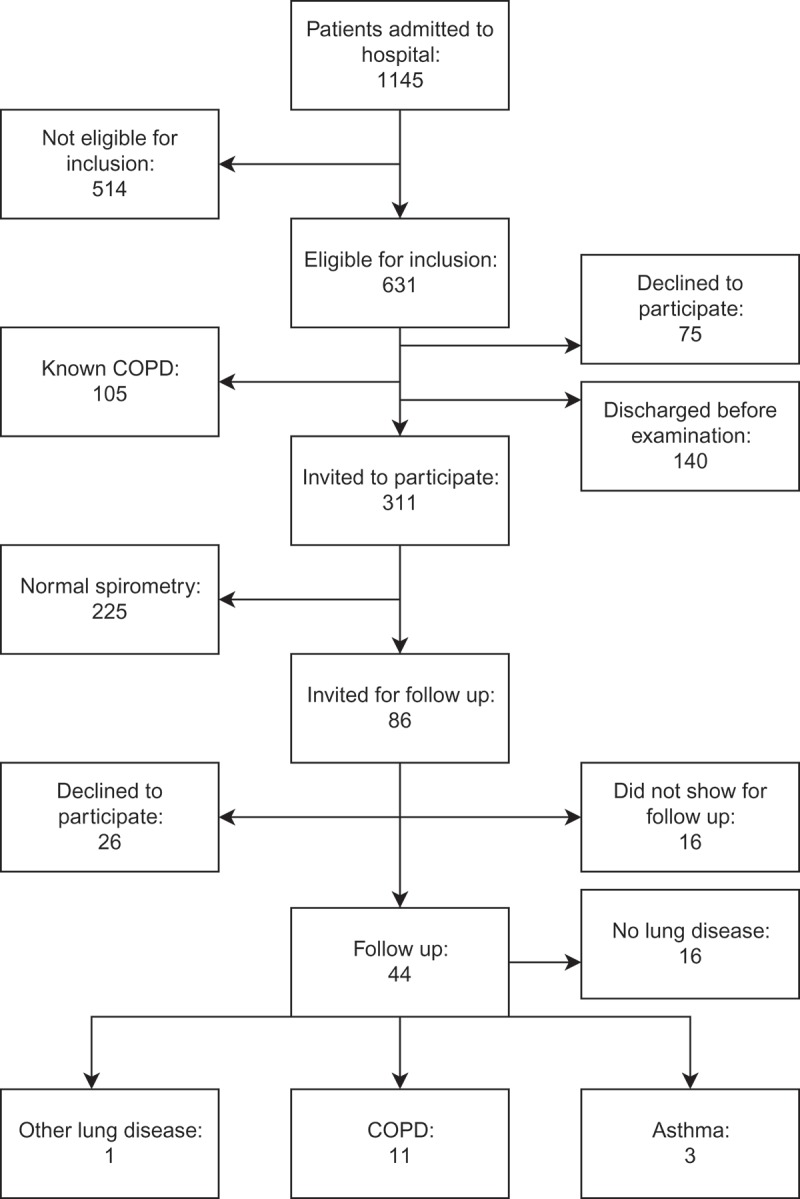
Flow chart of inclusion in the study.